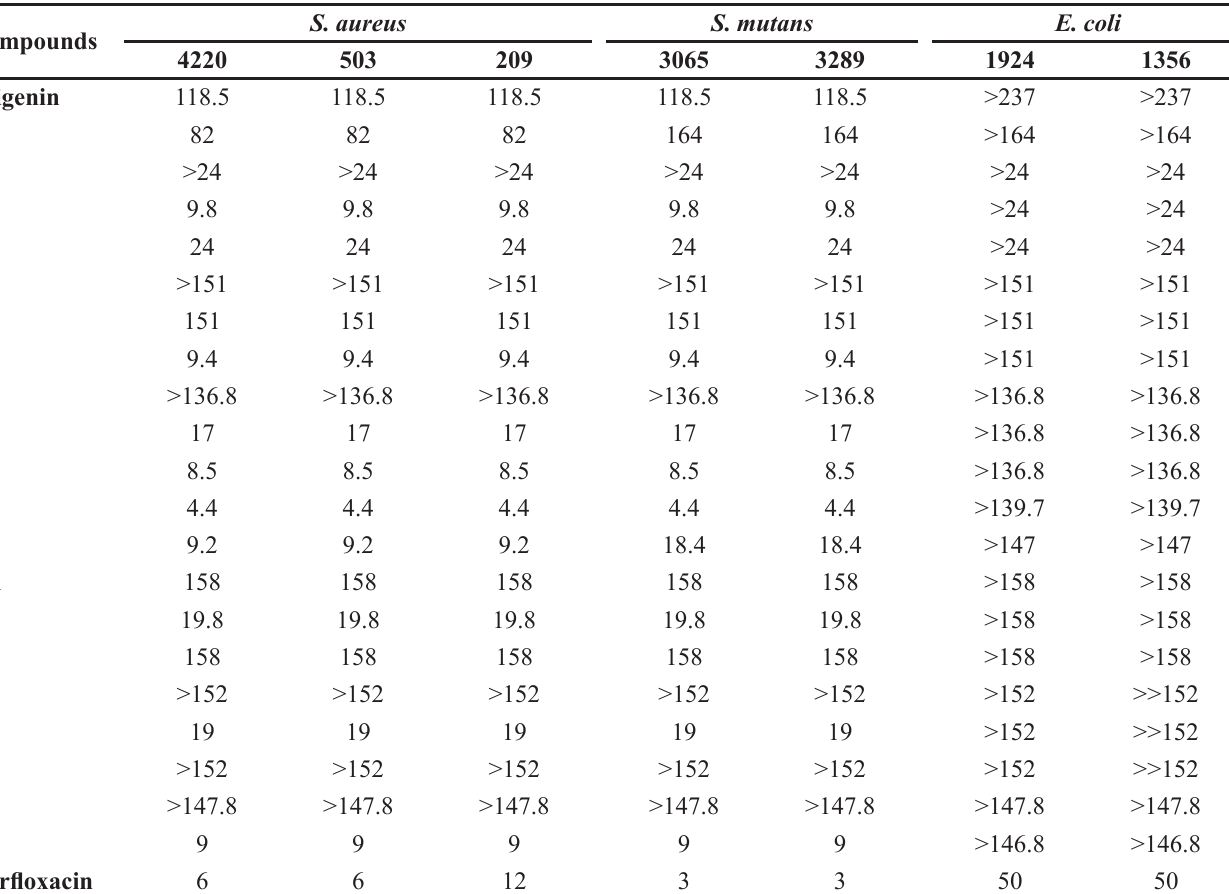
TABLE I - Inhibitory activity of compounds 4a-4t expressed as MIC (μM)